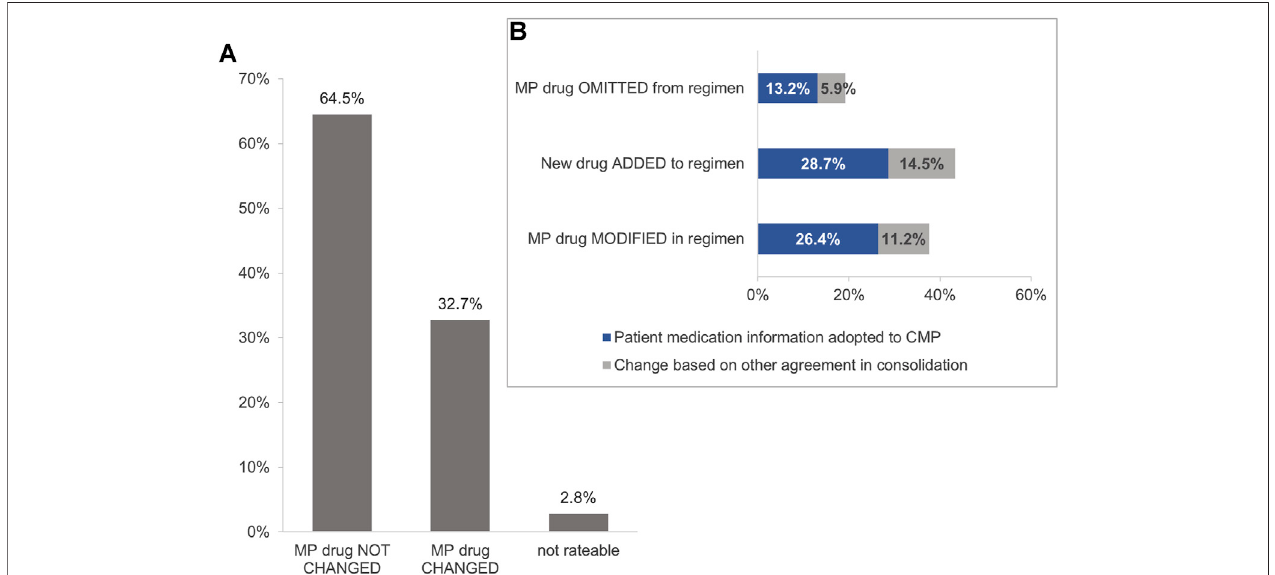
FIGURE 3 | (A) Impact of interdisciplinary consolidation on the physician-documented drug regimen of heart failure patients ( n (cid:1) 926 drugs*). *Fifty-nine drugs identi fi edonlyinthepatientinterviewwerenotincludedinAnalysisI.CMP,consolidatedmedicationplan;MP,medicationplan. (B) Changesinthedrugregimenresulting from the medication review ( n (cid:1) 303 drugs). Variations in the percentages or from 100% are due to rounding deviations in values.